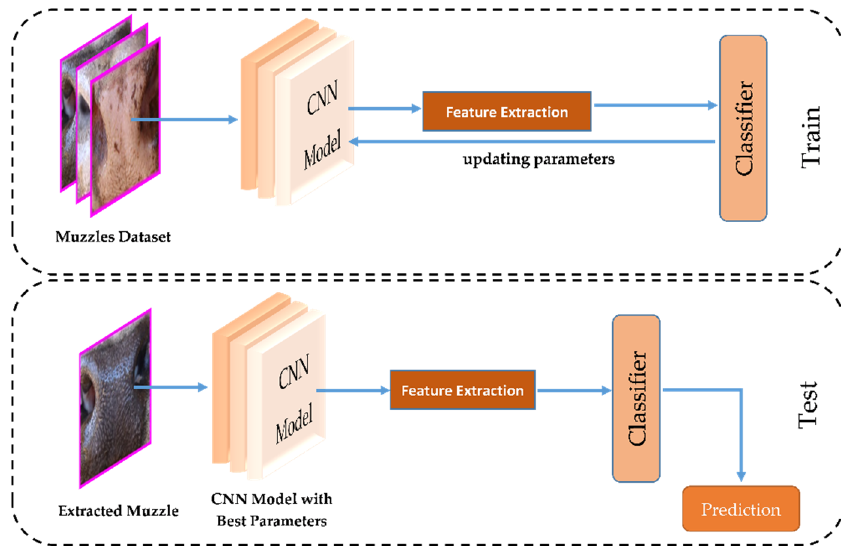
Figure 3. Overview of cattle biometric identification process.